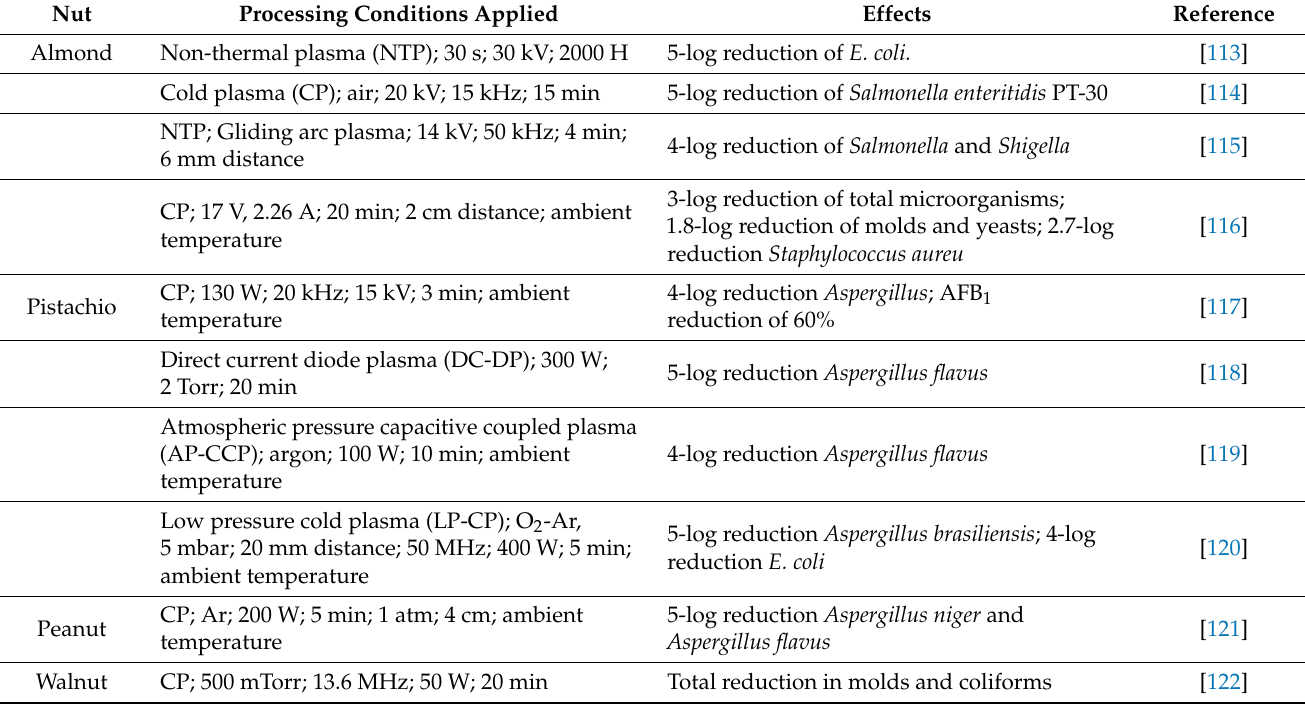
Table 1. Effect of cold plasma in